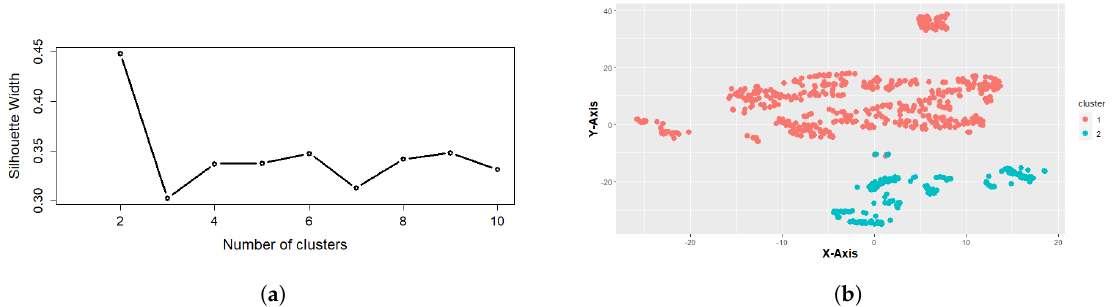
Figure 9. Data considered is Level-1 of the clustering tree, all cases belong to class-A (Broadband customers). ( a ) Curve of average silhouette width to identify optimal number of clusters; ( b ) Plot showing separation of cases with optimal number of clusters identified, two in this